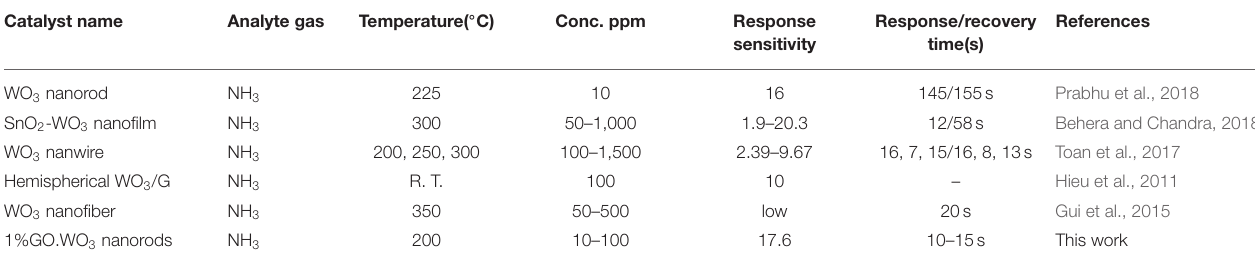
TABLE 1 | Comparison of ammonia gas sensing on some WO 3 based